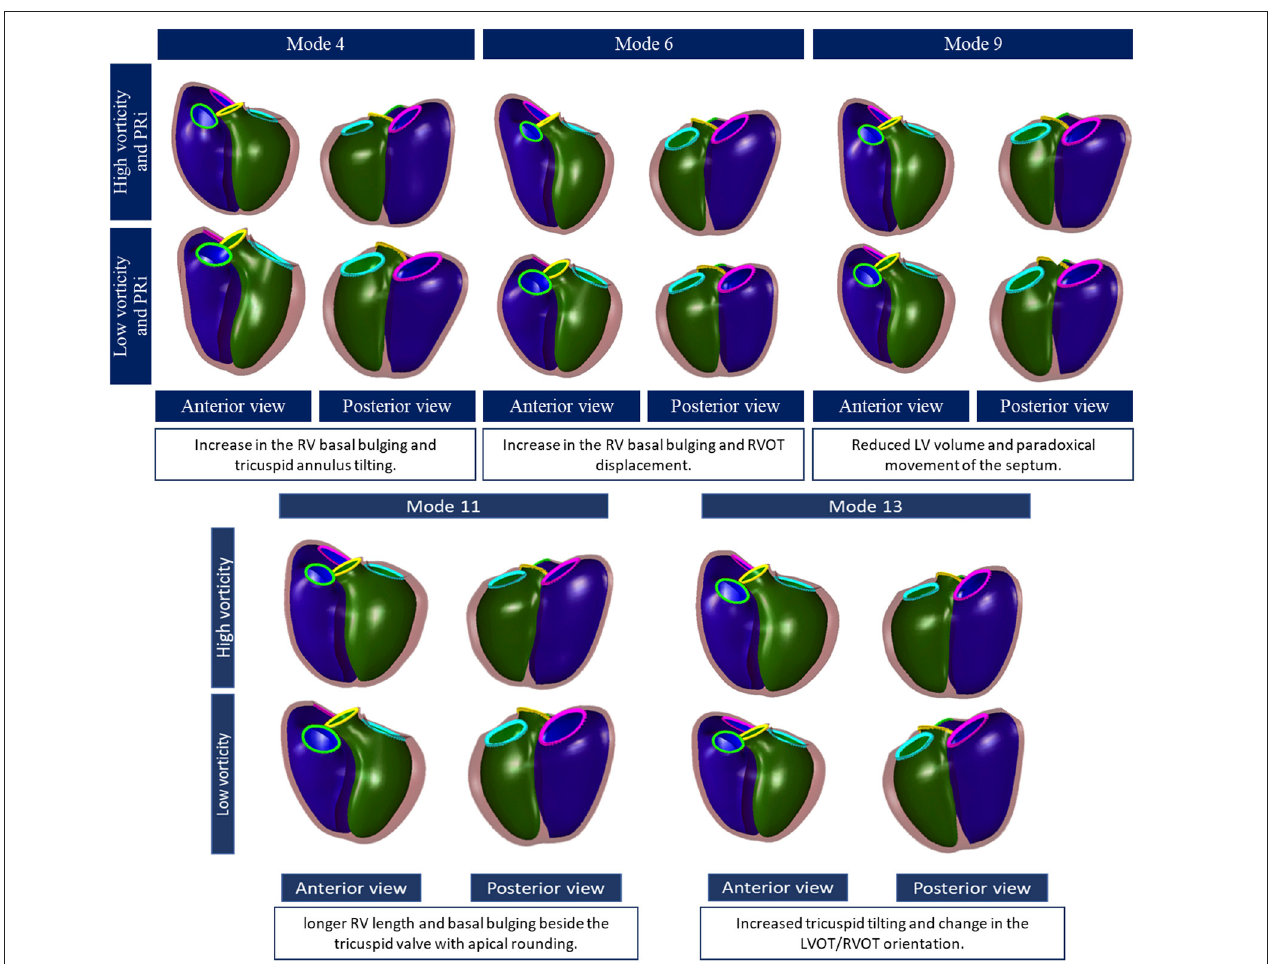
FIGURE 4 | Principal component shape variations associated with pulmonary regurgitant volume (top) and vorticity (bottom). The RV is shown in purple, left ventricle: green, the tricuspid valve: pink, the pulmonary valve: neon green, the aortic valve: yellow and mitral valve: blue. Each mode is shown in an anterior and posterior view with description